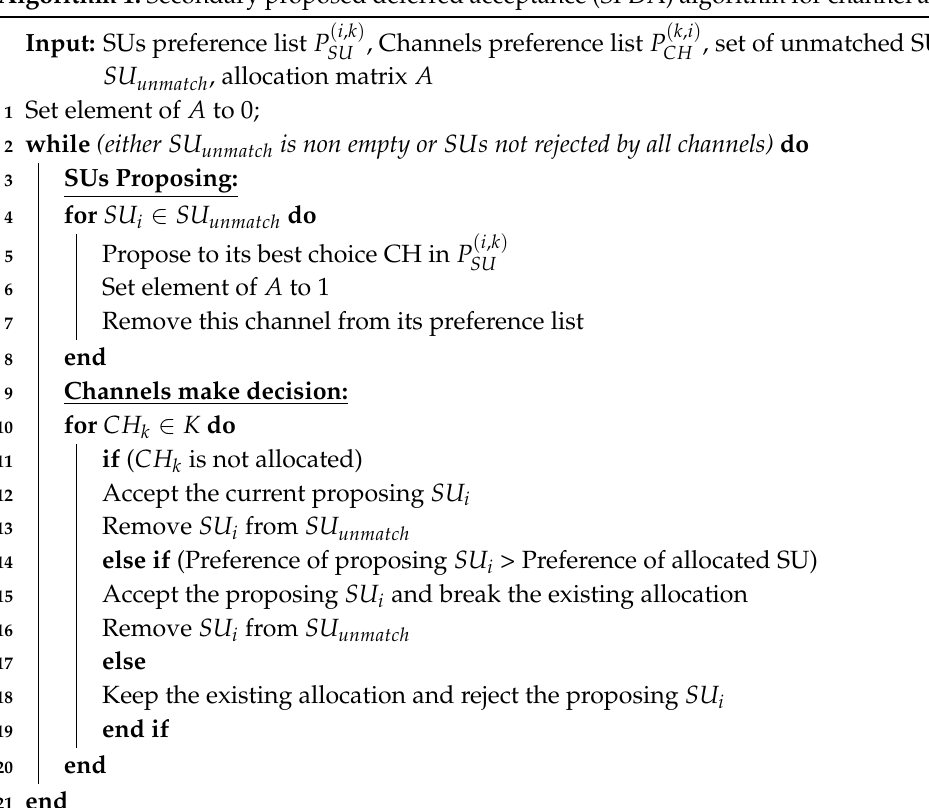
Algorithm 1: Secondary proposed deferred acceptance (SPDA) algorithm for channel